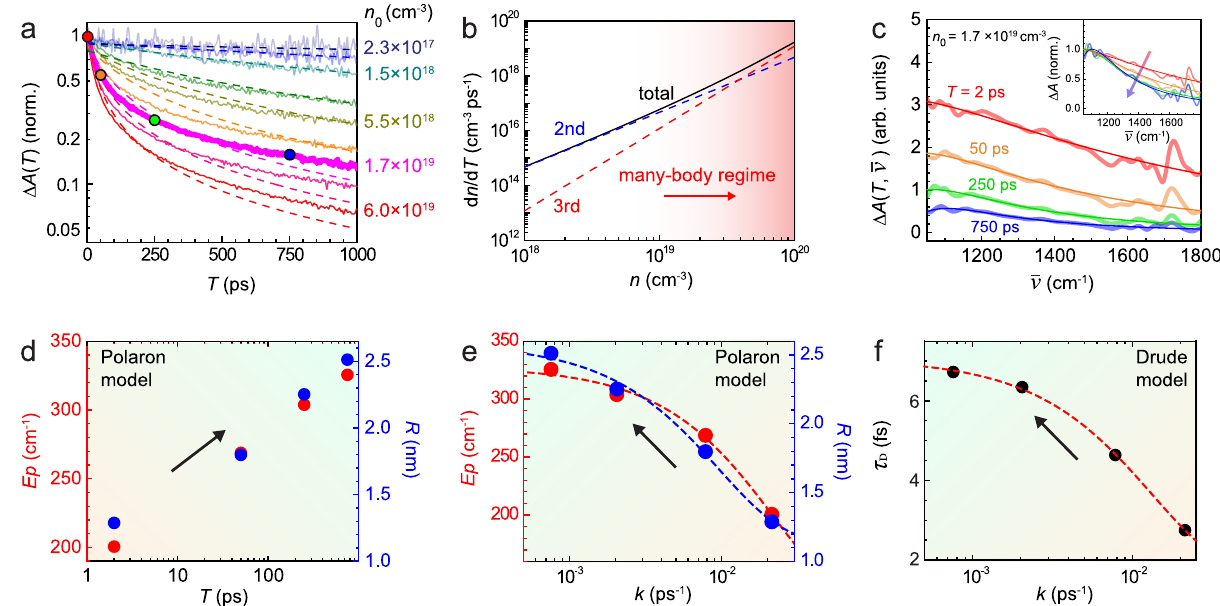
Fig. 3 | Transient broadband infrared absorption spectroscopy. a Transient absorption relaxation Δ A ( T ) for variable carrier density (solid lines), with global fi t to recombination model (Eq. (1), dashed). b Calculated carrier relaxation rate as functionofinjectedcarrierdensitybasedon fi tparameterfromA,withmany-body regime for densities above 10 19 cm − 3 . c Transient absorption spectra Δ A ð ν Þ at dif- ferent pump-probe delays T for an injected carrier density of 1.7×10 19 cm − 3 . Bold line-transientabsorptionspectra,thinline- fi ttingwithpolaronabsorptionmodel